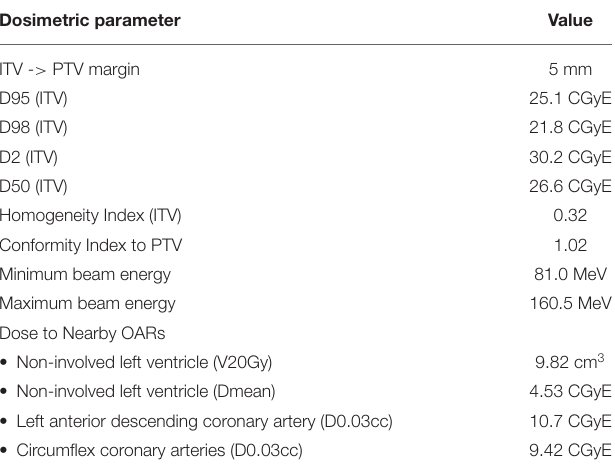
TABLE 2 | Proton treatment plan characteristics.